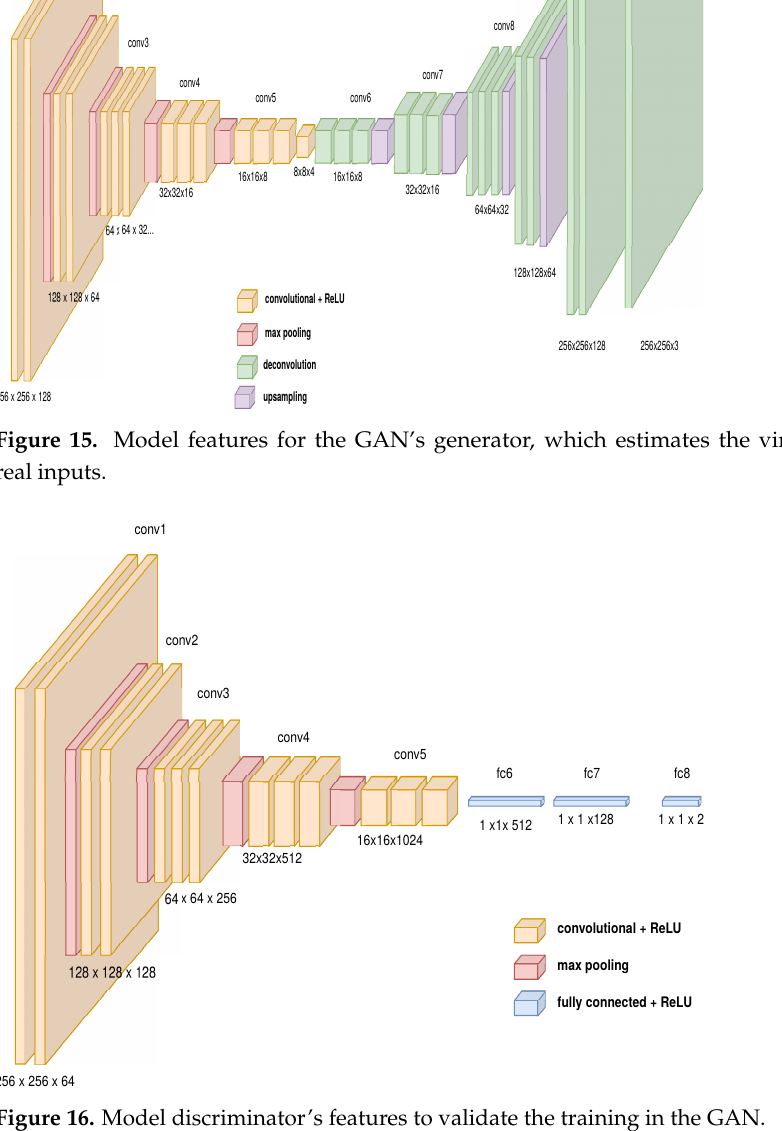
Figure 16. Model discriminator’s features to validate the training in the